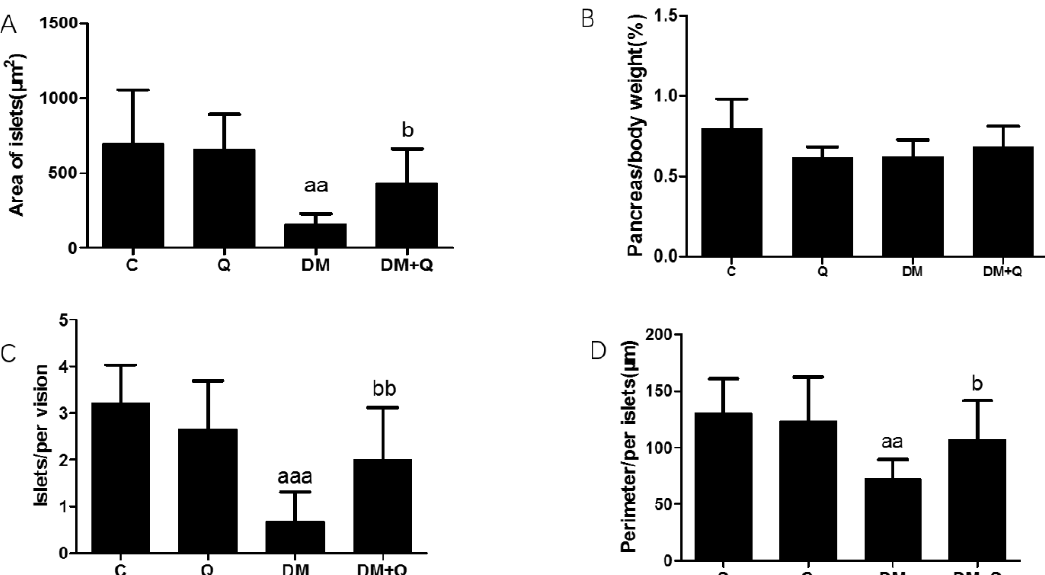
Figure 3. Morphological analysis of islets in mice. ( A ). Area of islets calculated by Mingmei camera at magnification: 200 × ( µ m 2 ) ( n = 3); ( B ). Pancreas / body weight (%) ( n = 10); ( C ). Numbers of islets /